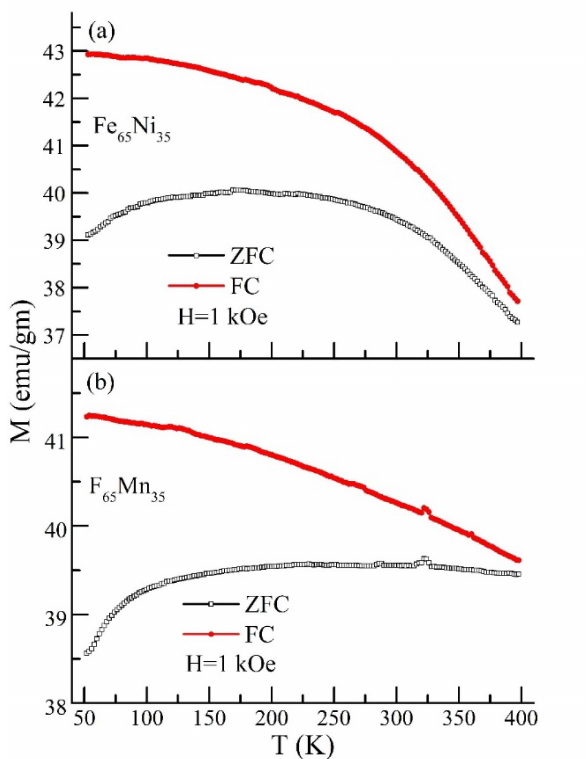
Figure 3. Temperature response of DC magnetization results measured at 1 kOe under zero field cooled (ZFC) and field cooled (FC) conditions: ( a ) ZFC and FC magnetization curve for Fe 65 Ni 35 ; ( b ) ZFC and FC magnetization curve for Fe 65 Mn 35